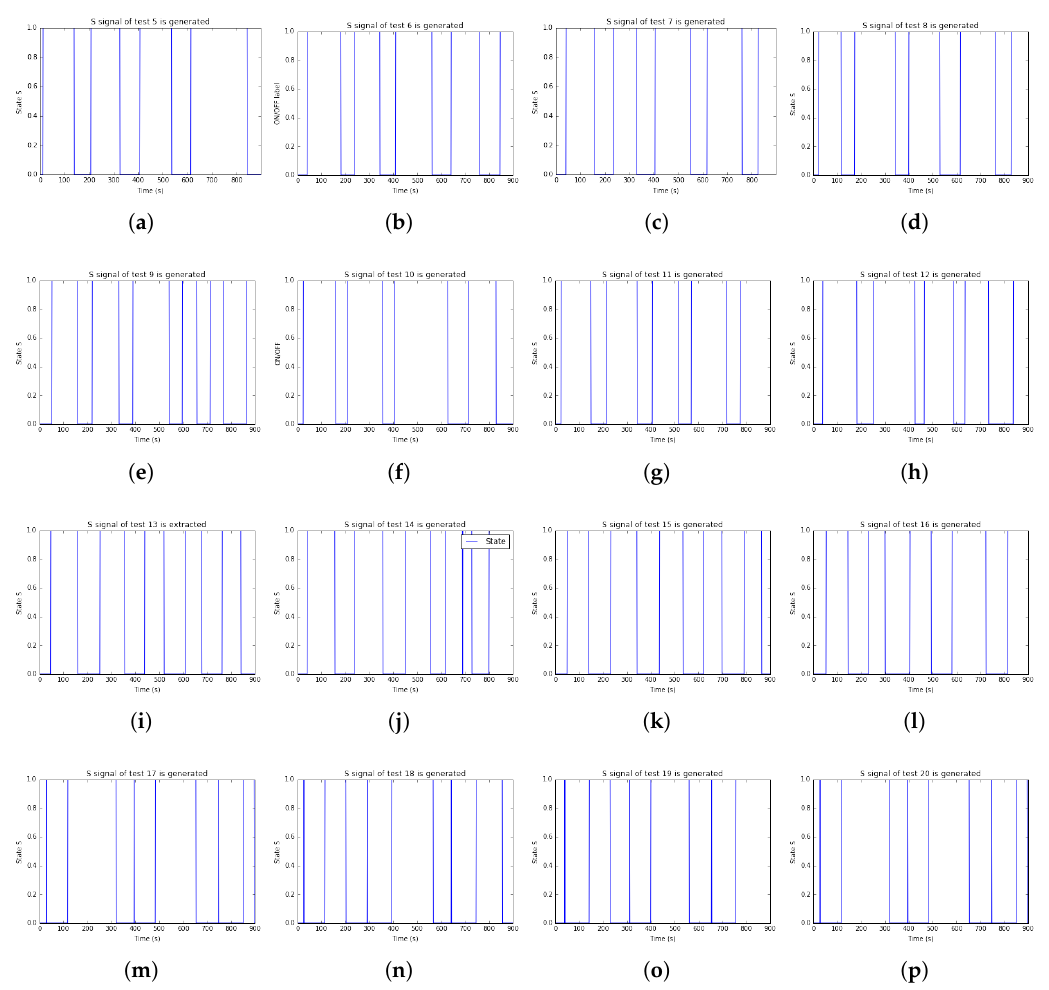
Figure A1. State S signals of test 5 to test 20